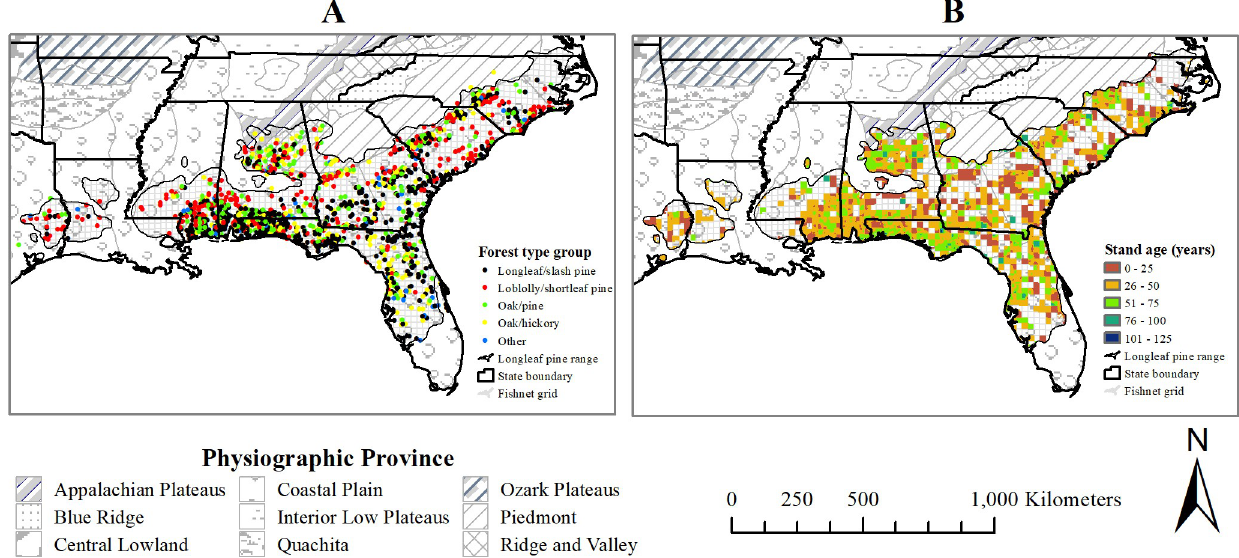
Fig 2. Approximate spatial distribution of the A) plots with associated dominant forest type groups and B) stand age classes in the 2004 dataset (first inventory interval 1997–2010). (Shapefile data sources: US state boundary [25], Physiographic Province [21], and Longleaf pine range [26]).